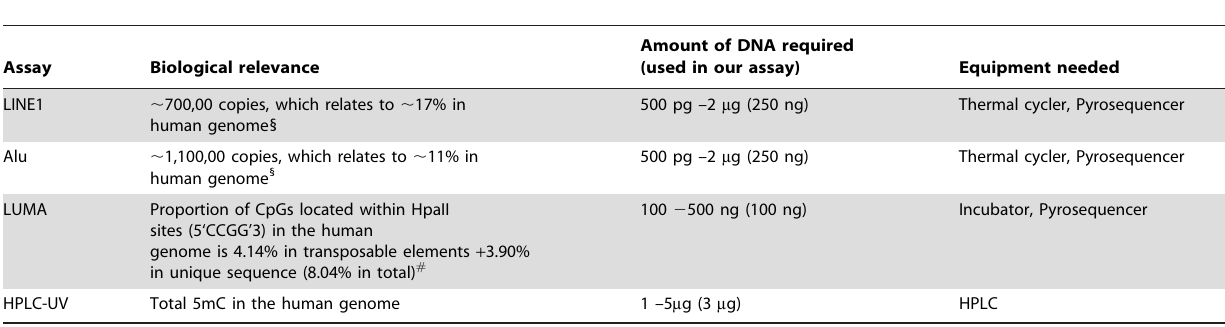
Table 1. Overview of various assays to assess global DNA methylation, depicting their biological relevance.